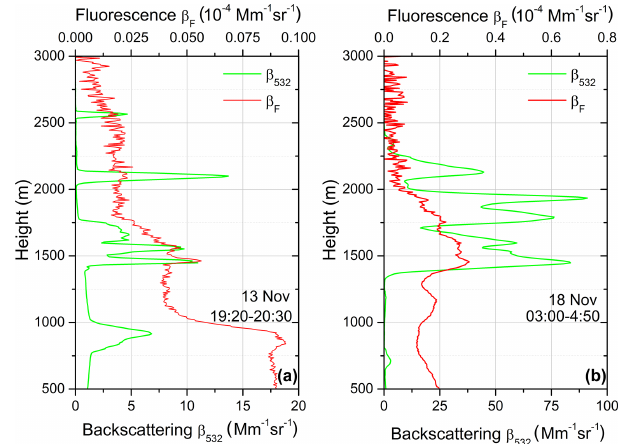
Figure 4. Aerosol ( β 532 ) and fluorescence ( β F ) backscattering co- efficients on 13 and 18 November 2019.